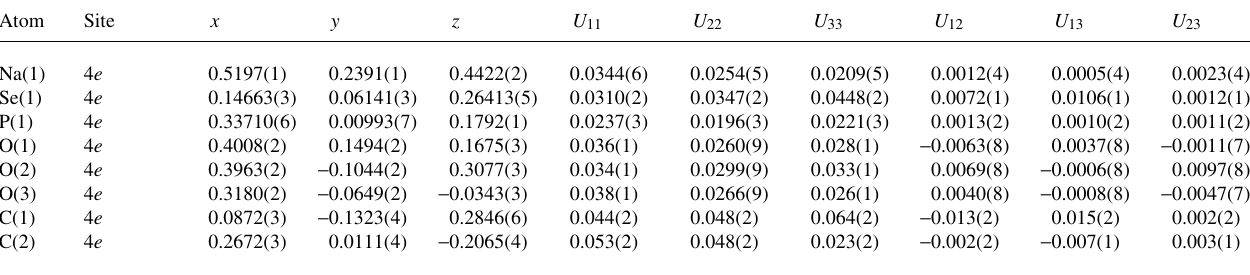
Table 3. Atomic coordinates and displacement parameters (in Å 2 )